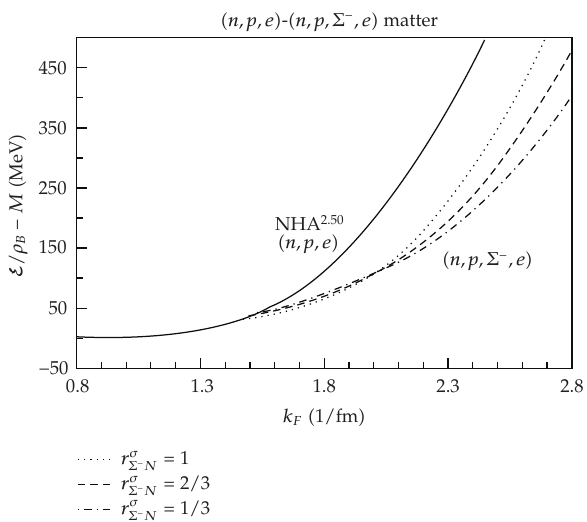
Figure 1: The binding energies of (cid:7) n,p,e (cid:8) and (cid:7) n,p, Σ − ,e (cid:8) . The onset density of Σ − is about k F (cid:5) 1 . 6fm − 1 as shown in the figure. The ratios of Σ − -coupling constant on σ are (cid:7) dotted line (cid:8) r σ Σ − (cid:5) 2 / 3, (cid:7) dotted-dashed line (cid:8) r σ (cid:7) dashed line (cid:8) r σ Σ − N fixed as in Table